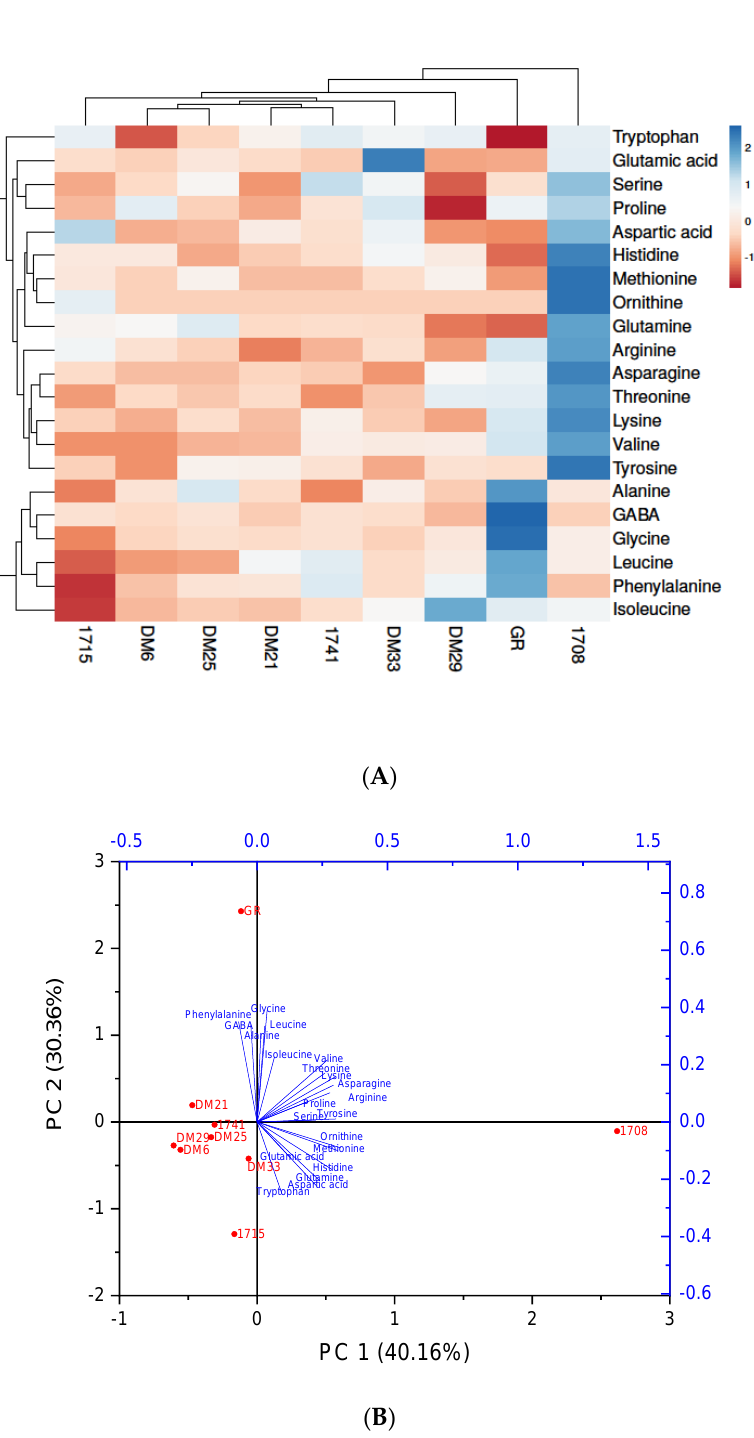
Figure 4. Different colored rice varieties have different amino acid levels. ( A ) The heat map depicts varying levels of amino acid, with blue indicating a higher level of amino acid and red indicating a lower level of amino acid. ( B ) By comparing PC 1 and PC2, the principal component analysis (PCA) of rice varieties was demonstrated.